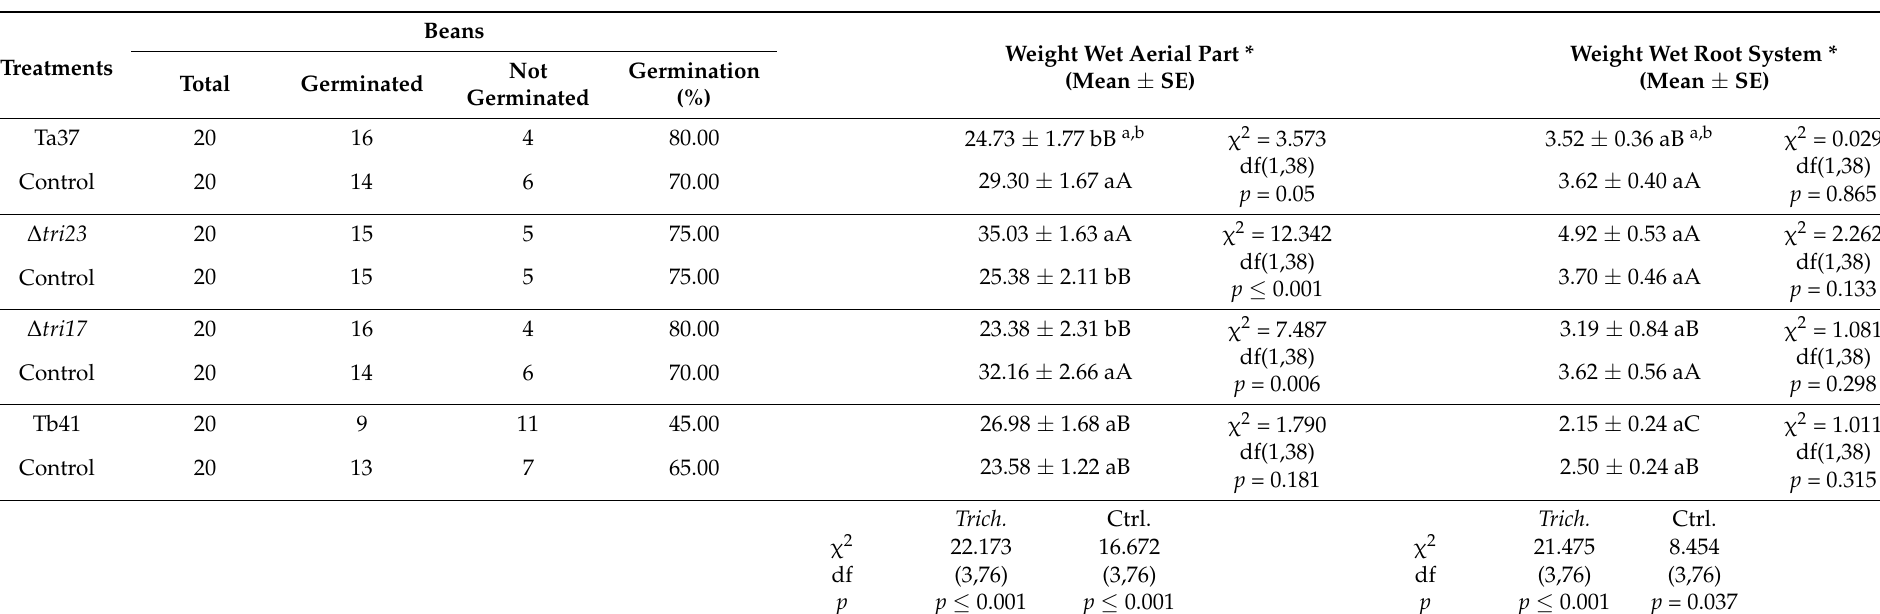
* Test for equality of germination capacity of undamaged beans between treatments and controls (Log Rank; Mantel-Cox). a Different lowercase letters indicate significant differences between treated and untreated beans (control) within each strain; ( p < 0.05). b Different capital letters indicate significant differences among fungal strains (on one hand) and among their controls (on the other hand); ( p <